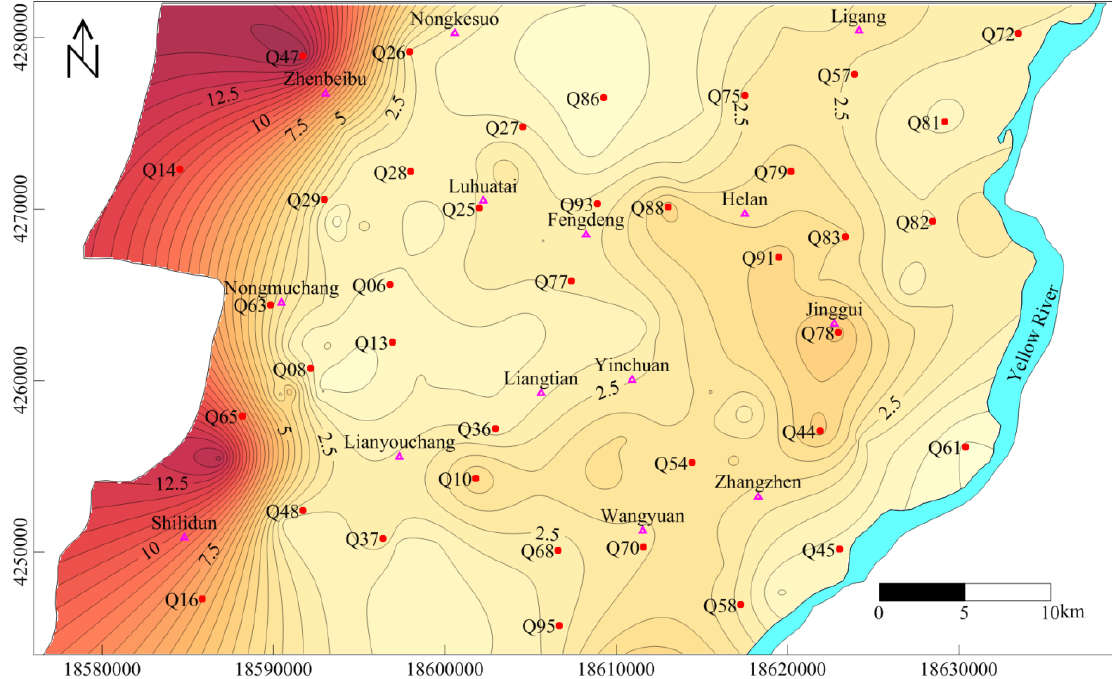
Figure 4. Distribution of groundwater depth (m) (March